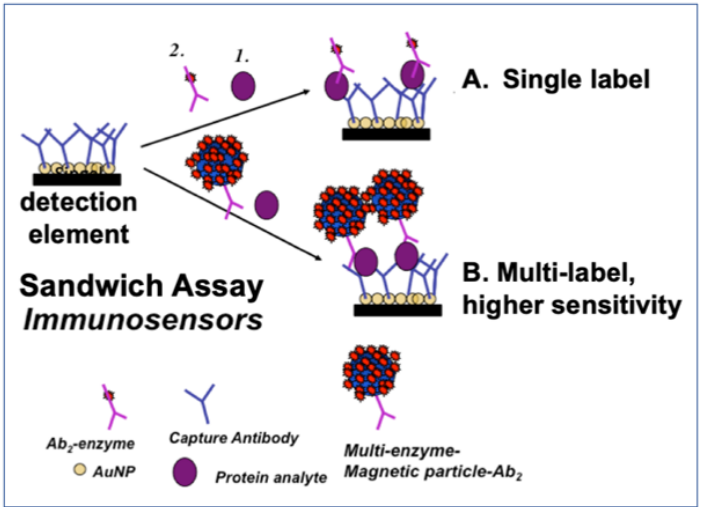
Figure 1. Principles of ELISA-like sandwich assays for proteins utilizing a capture antibody (Ab 1 ) on a surface and a single or multiple labeled detection antibody (Ab 2 ). Detection of labels can employ several techniques, including optical and electrochemical methods.